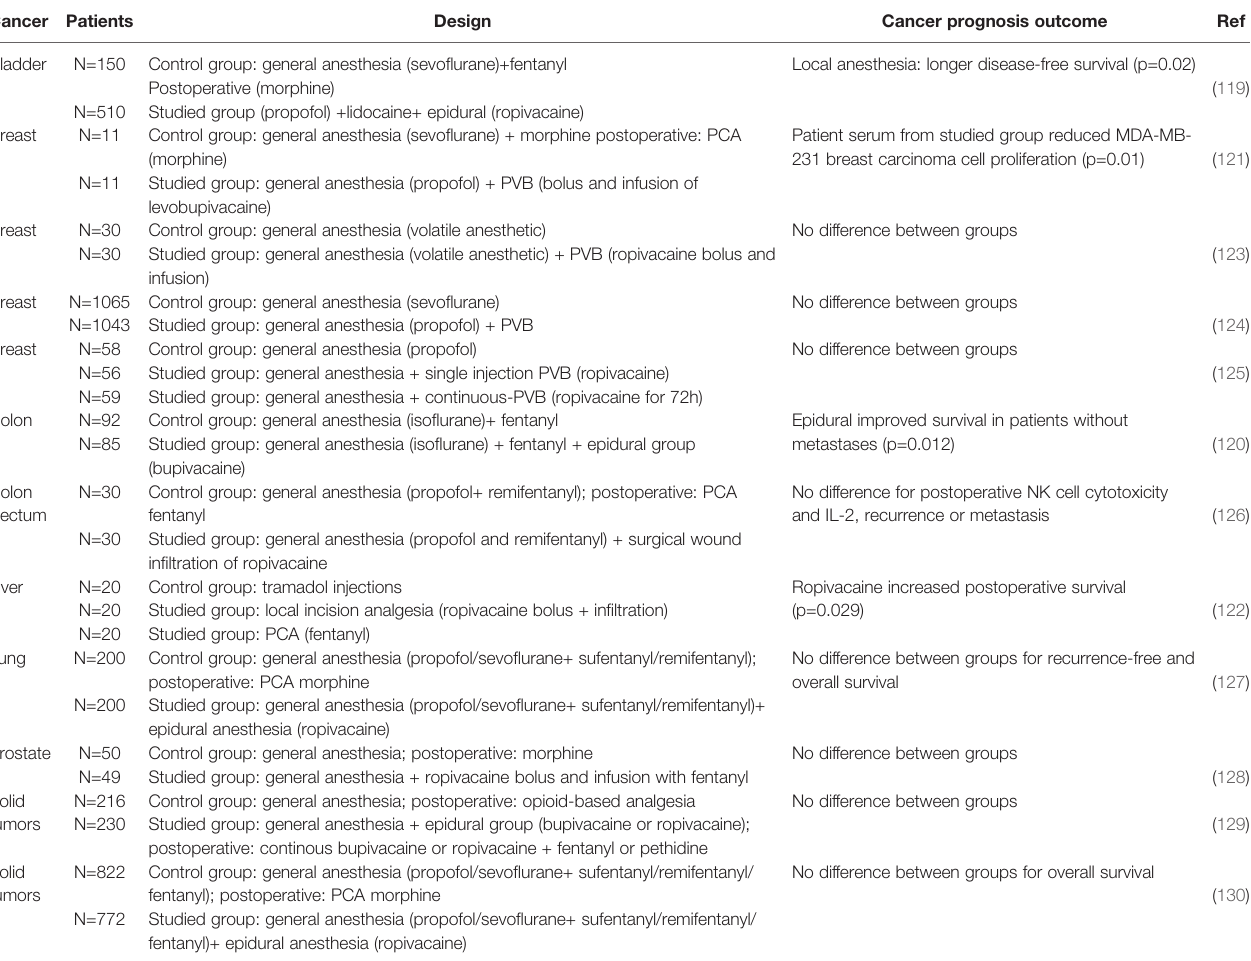
TABLE 4 | Randomized controlled trials assessing local anesthetics impact on cancer prognosis. Cancer Patients Design Cancer prognosis outcome